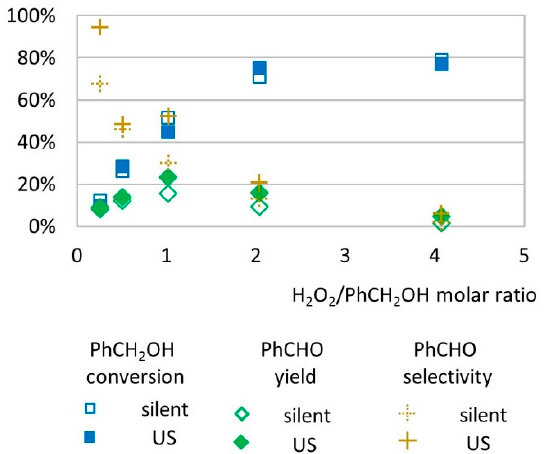
Figure 1. Oxidation of PhCH 2 OH as a function of H 2 O 2 / substrate molar ratio in silent conditions and under US irradiation (20 kHz). Reaction conditions: 571 mM PhCH 2 OH, 1% molar eq. FeSO 4, 5.61 mL H 2 O, 62 °C, 15 min. Silent conditions: Argon bubbling; US conditions: 20 kHz, P acous = 47.9 W L − 1 h − 1 , 13 mm probe.